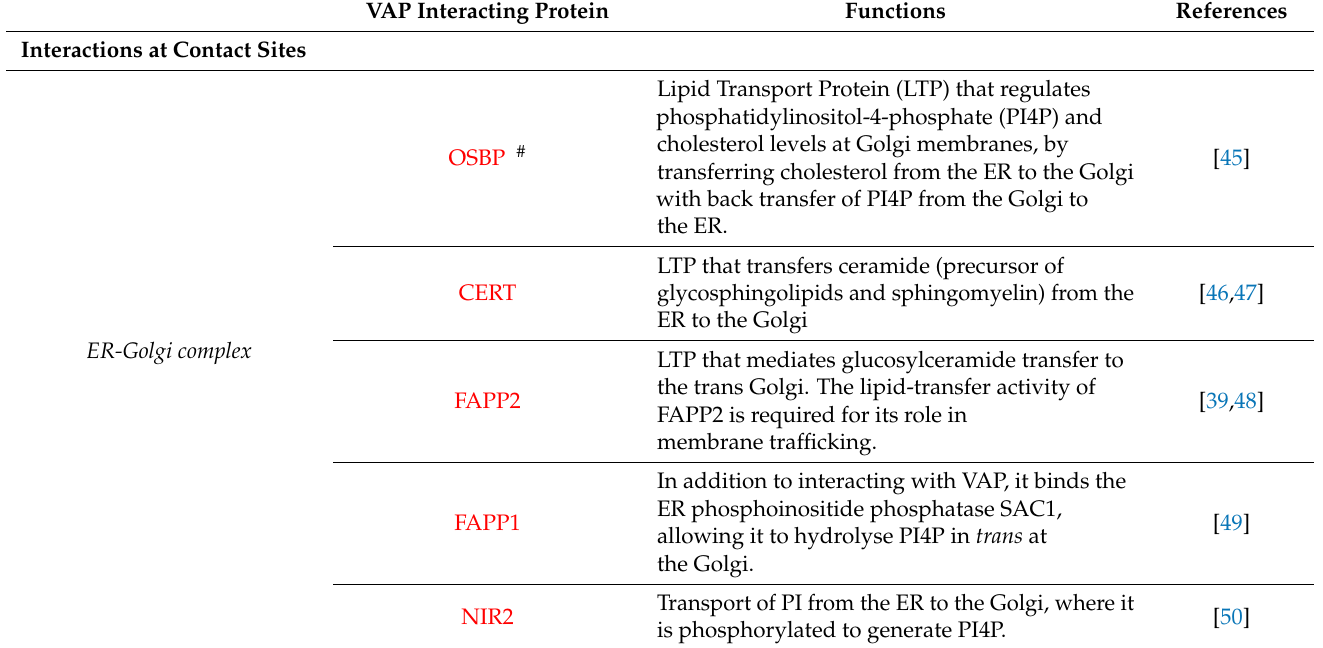
Table 1. Interactions of the VAP proteins and their functional roles *. VAP Interacting